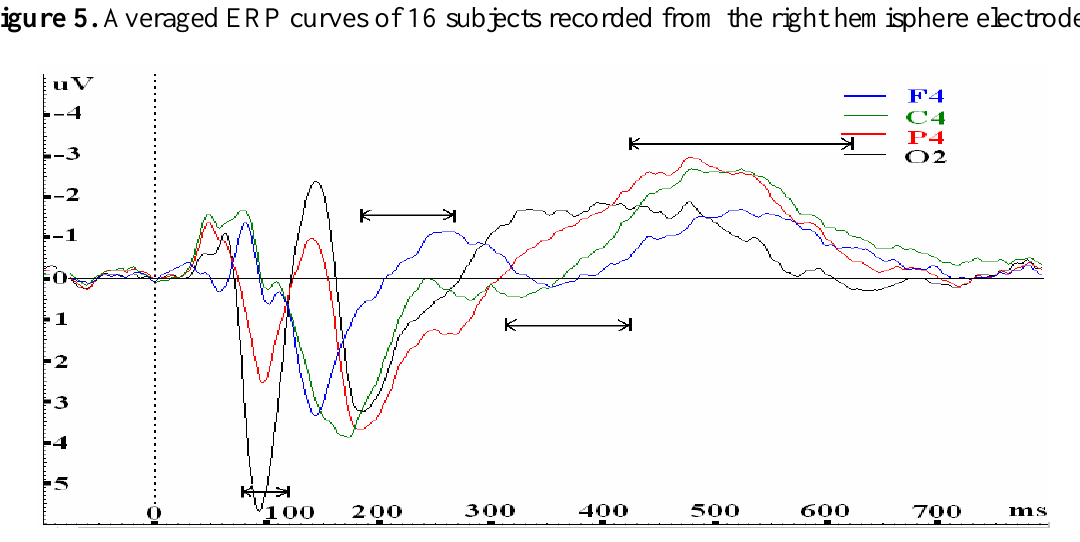
Figure 5. Averaged ERP curves of 16 subjects recorded from the right hemisphere electrodes.